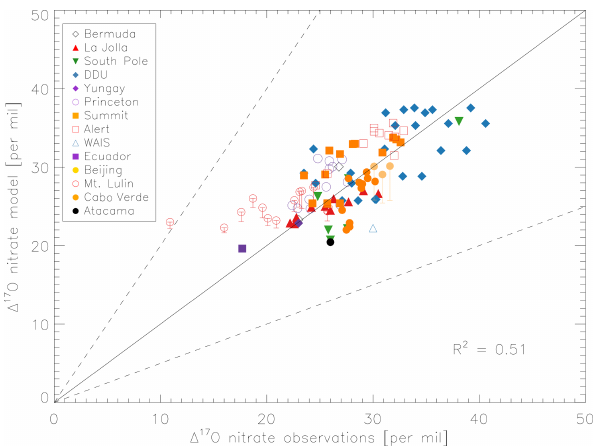
Figure 5. Comparison of monthly-mean modeled (cloud chemistry) and observed (cid:49) 17 O(nitrate) at locations where there are enough ob- servations to calculate a monthly mean. References for the obser- vations are in the text. The error bars represent different assump- tions for calculated modeled A values for nighttime reactions as described in the text. Error bars for Beijing and Mt. Lulin reflect the range of possible modeled A values for nighttime reactions as de- scribed in the text. The y = x (solid line) and y = 2 x and y = 0 . 5 x (dashed) are shown.